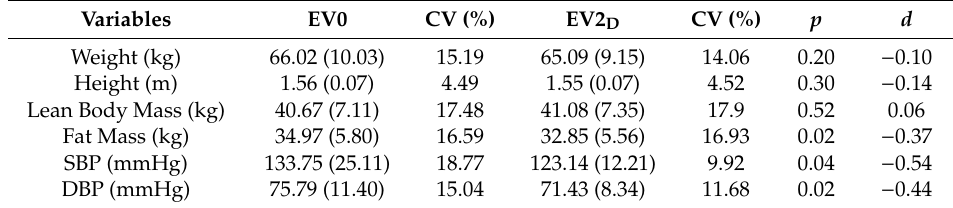
Table1. Body composition and Blood Pressure following two years of EFAM-UV © expressed as mean ( SD ).